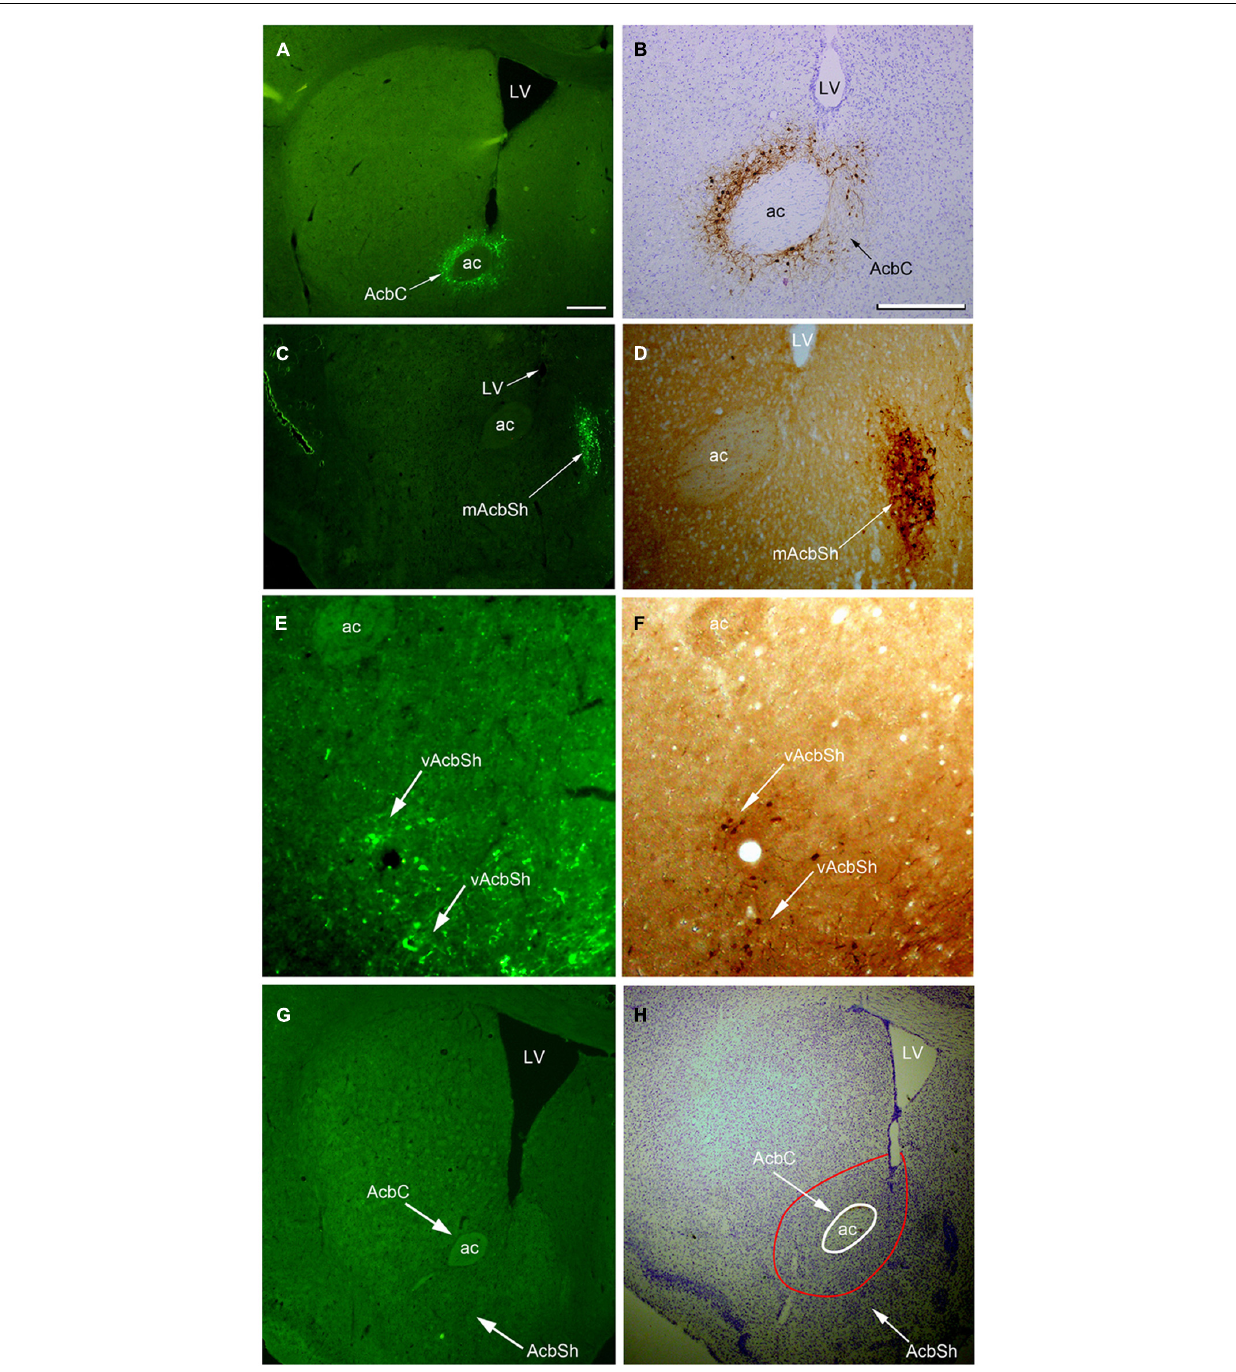
vAcbSh, visualized by fluorescence and ABC techniques. Positive staining with hrGFP-IRc occupied vAcbSh in (E,F) in two labeled adjacent sections in this case (M-21). (G,H) A brain section from the wild type mouse with fluorescent staining (G) and ABC techniques with Nissl-counterstaining (H) showing no hrGFP-IRc in Acb. Abbreviations are as follows: AC, anterior commissural nucleus; LV, lateral ventricle; AcbC, nucleus accumbens core; AcbSh, nucleus accumbens shell; mAcbSH, medial AcbSh; vAcbSh, ventral AcbSh. Scale bar = 500 μ m in (A) ; 100 μ m